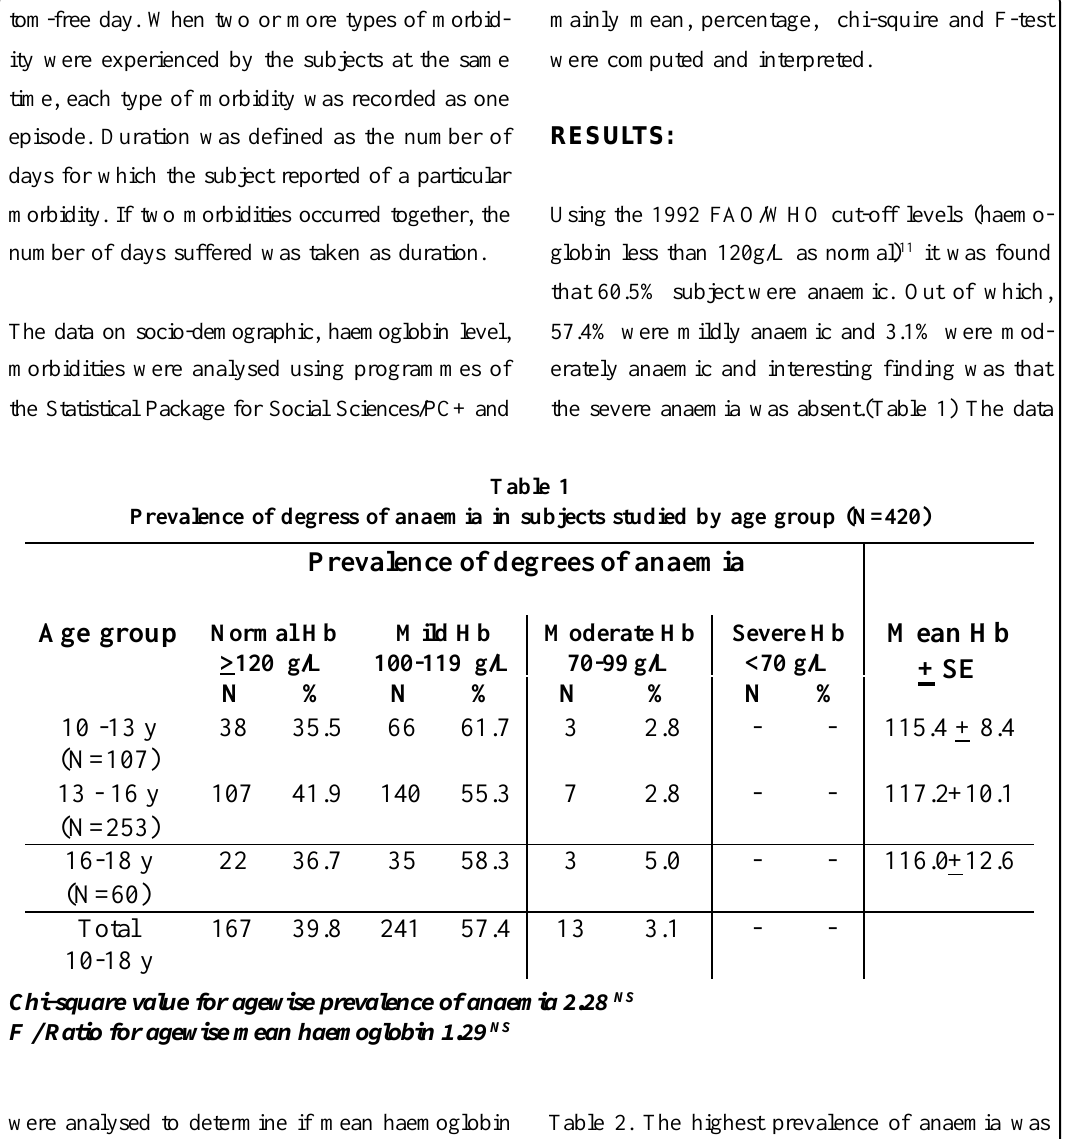
Table 2. The highest prevalence of anaemia was seen among Brahmins (66.7%) as compared to 55.4% in Chhetries and 52.3 % in Newars, al- though this was not statistically significant. The mean haemoglobin levels however were signifi- cantly higher (p<0.01) in Newars (119.3g/L) and in Chhetries (117.4g/L) as compared to the